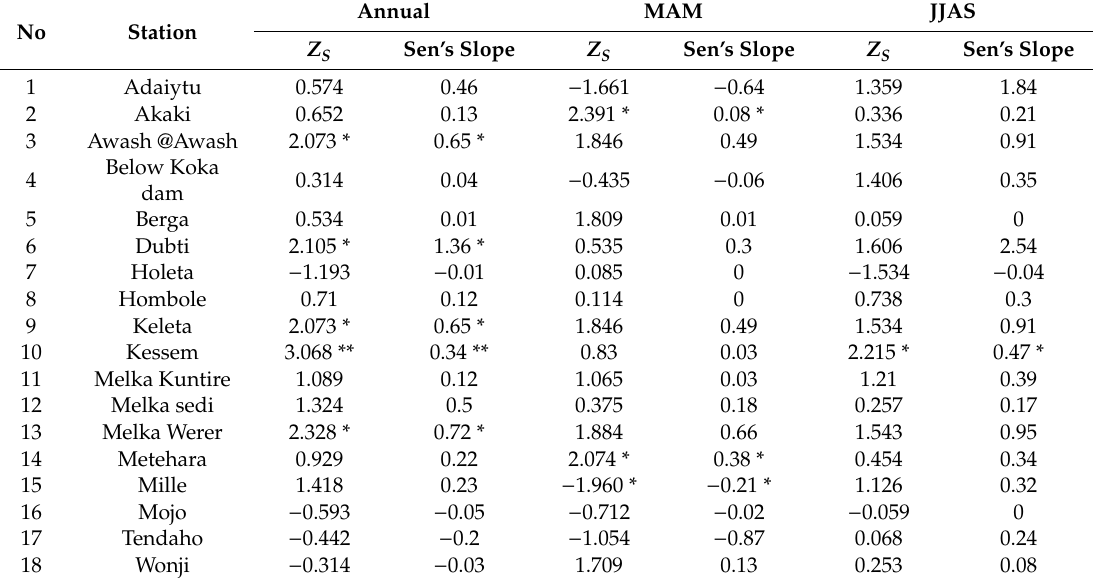
Table 4. The summary of streamflow trend using Mann-Kendell and Sen’s slope test in the